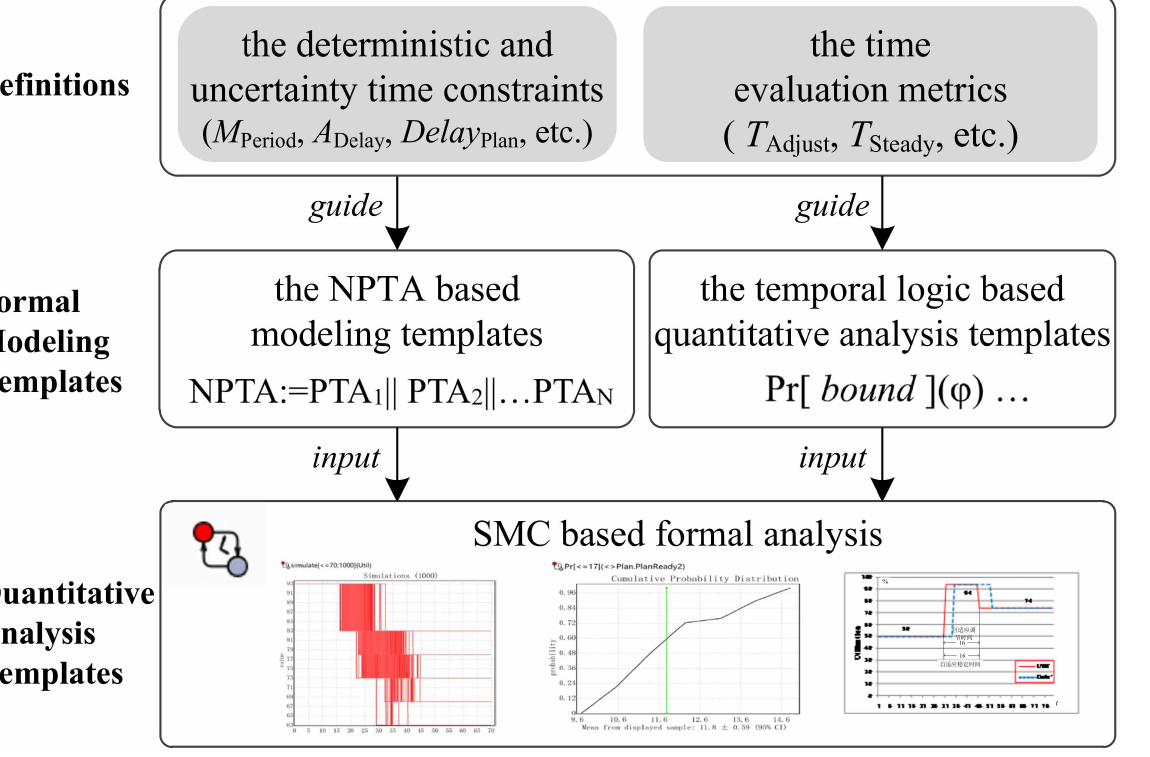
Figure 2. An overview of the Timed-SAS